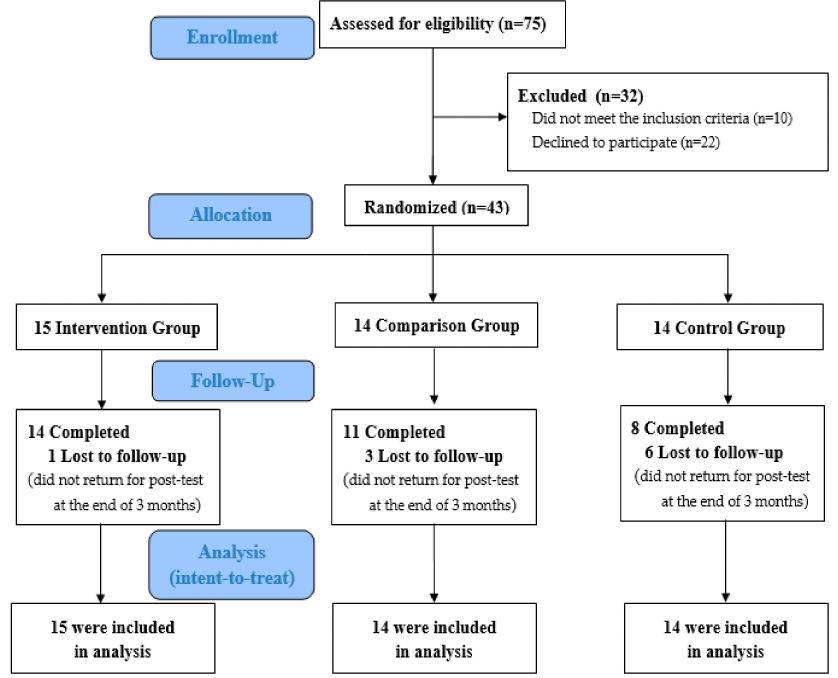
Figure 1. CONSORT study flow chart.